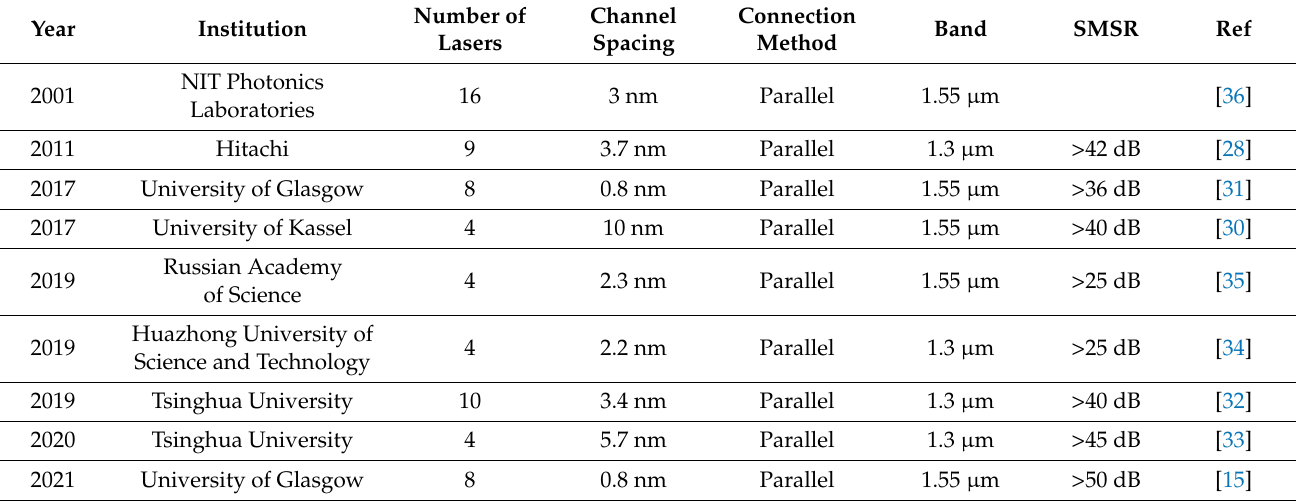
Table 1. Recent achievements in the fabrication of DFB laser arrays using